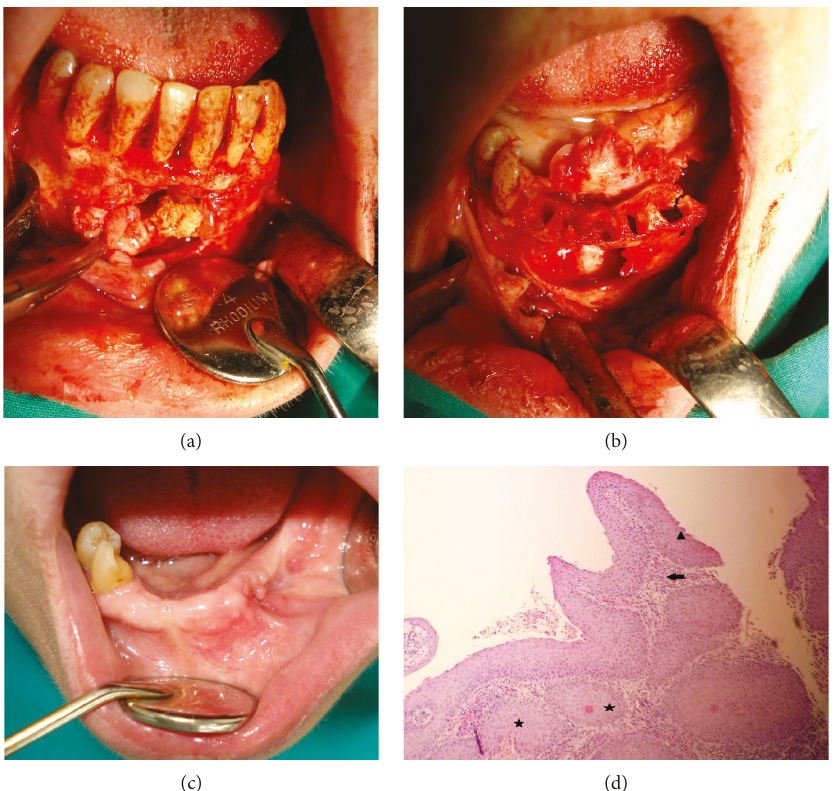
Figure 9: (a) Procedure for removal of the cystic wall lining and contents. (b) Cavity in the bone after removal of the cyst and extraction of six teeth. (c) Clinical appearance 2 months after surgery. (d) In fl amed fi brous wall lined with nonspeci fi c strati fi ed squamous epithelium (arrow) with focally corrugated surface (arrowhead). Satellite cysts and solid islands in the wall